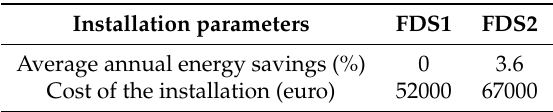
Table A3. Installation parameters—fluid distribution system.